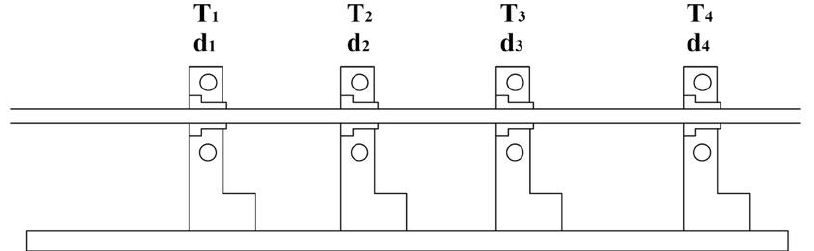
Figure 1. Position of die blocks for the pultrusion of thermoplastic GF/PP bars of Ø 6 mm, manu- factured from inhouse-made PCTs.